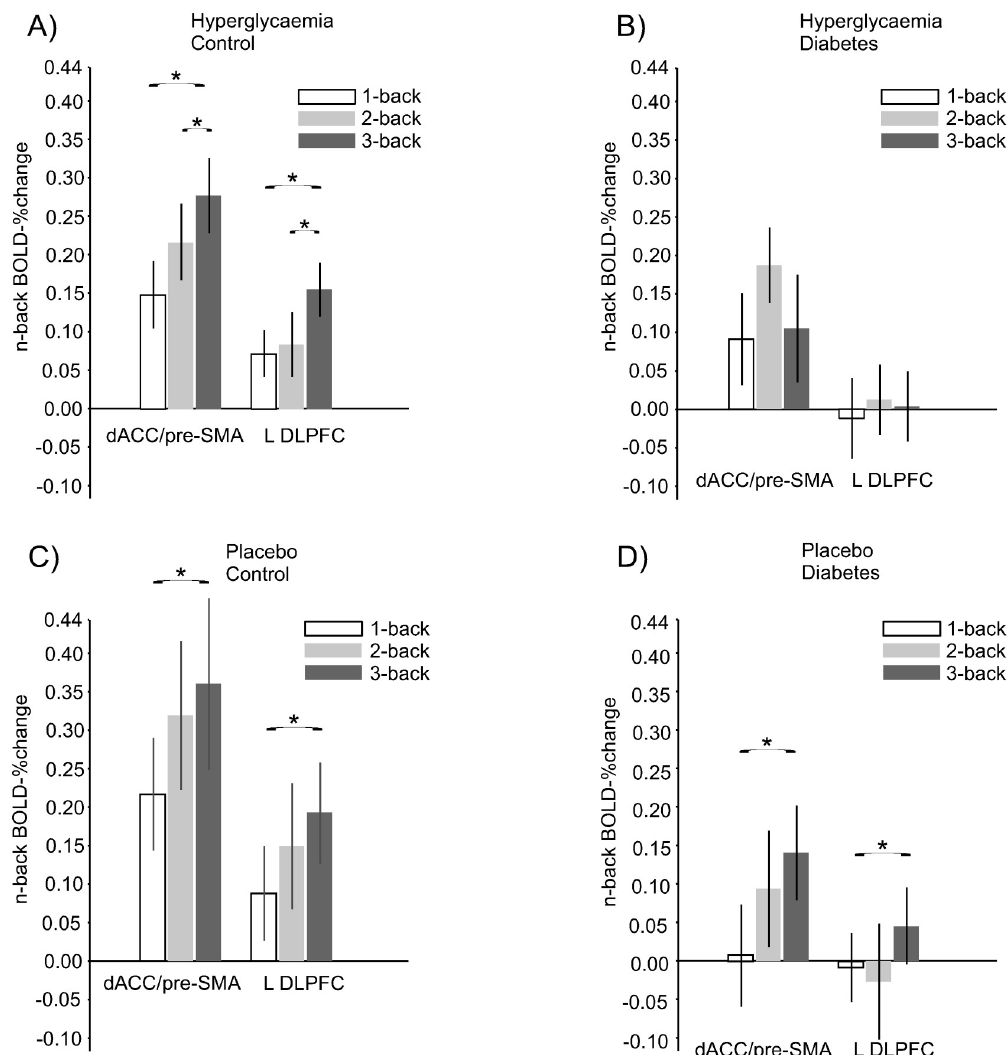
Fig 3. Load-dependent PFC BOLD functions during a test of working memory. (A, B) N-1/2/3-back BOLD signal relative to baseline in controls and participants with type 2 diabetes during hyperglycaemia (C, D) an placebo clamp. Data are presented as mean ± SE. dACC = dorsal anterior cingulate cortex; pre-SMA = pre-supplementary motor area; L = Left; DLPFC = dorsolateral prefrontal cortex.